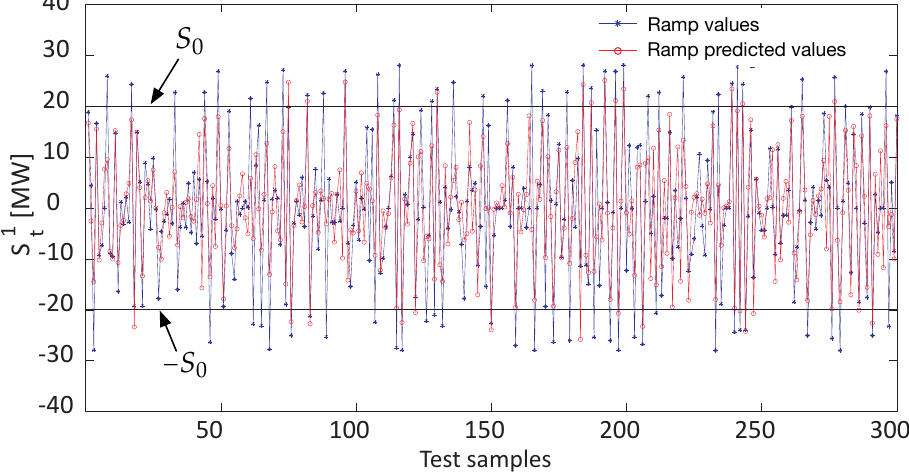
Figure 3. Estimation of the ramp function S 1 t ( Equation (1) ) obtained by our proposed hybrid approach when using the GPR as the ML regressor in Wind Farm B. The predicted series exhibits RMSE ≈ 5.98 MW, MAE ≈ 4.43 MW, s (+ramp) = 52.10%, s ( − ramp) = 58.25% and s (no ramp) = 91.71% (see Table 4).